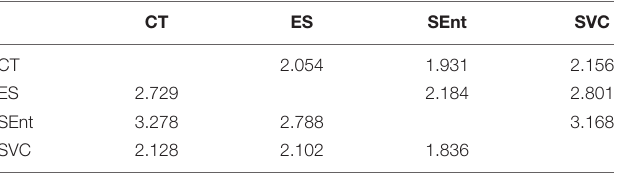
TABLE 4 | Inner variance inflation factor (VIF) analysis.